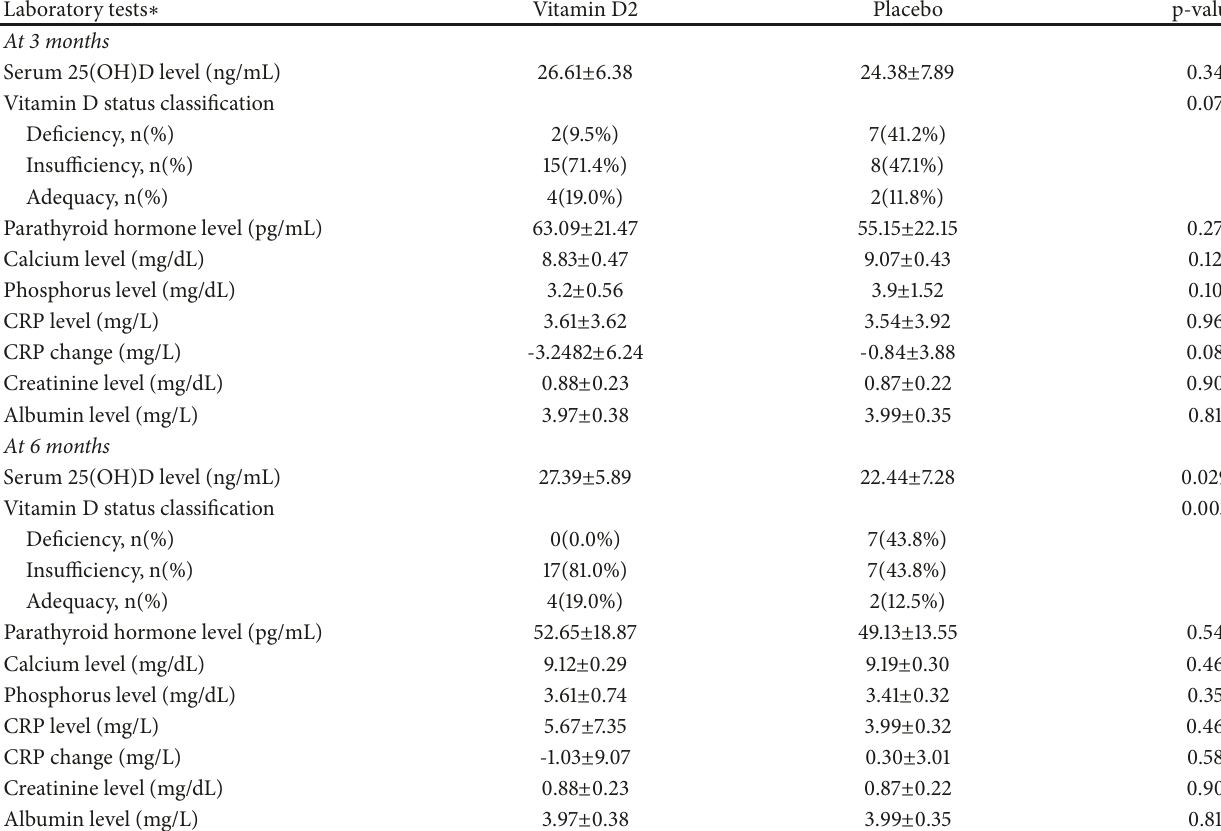
Table 3: Laboratory test results at the 3-month and 6-month